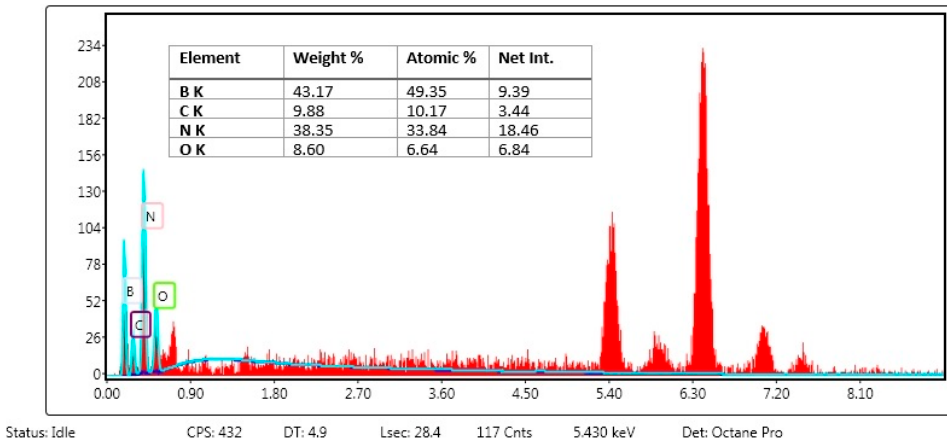
Figure 3. EDX analysis of the hBN-FA complex.